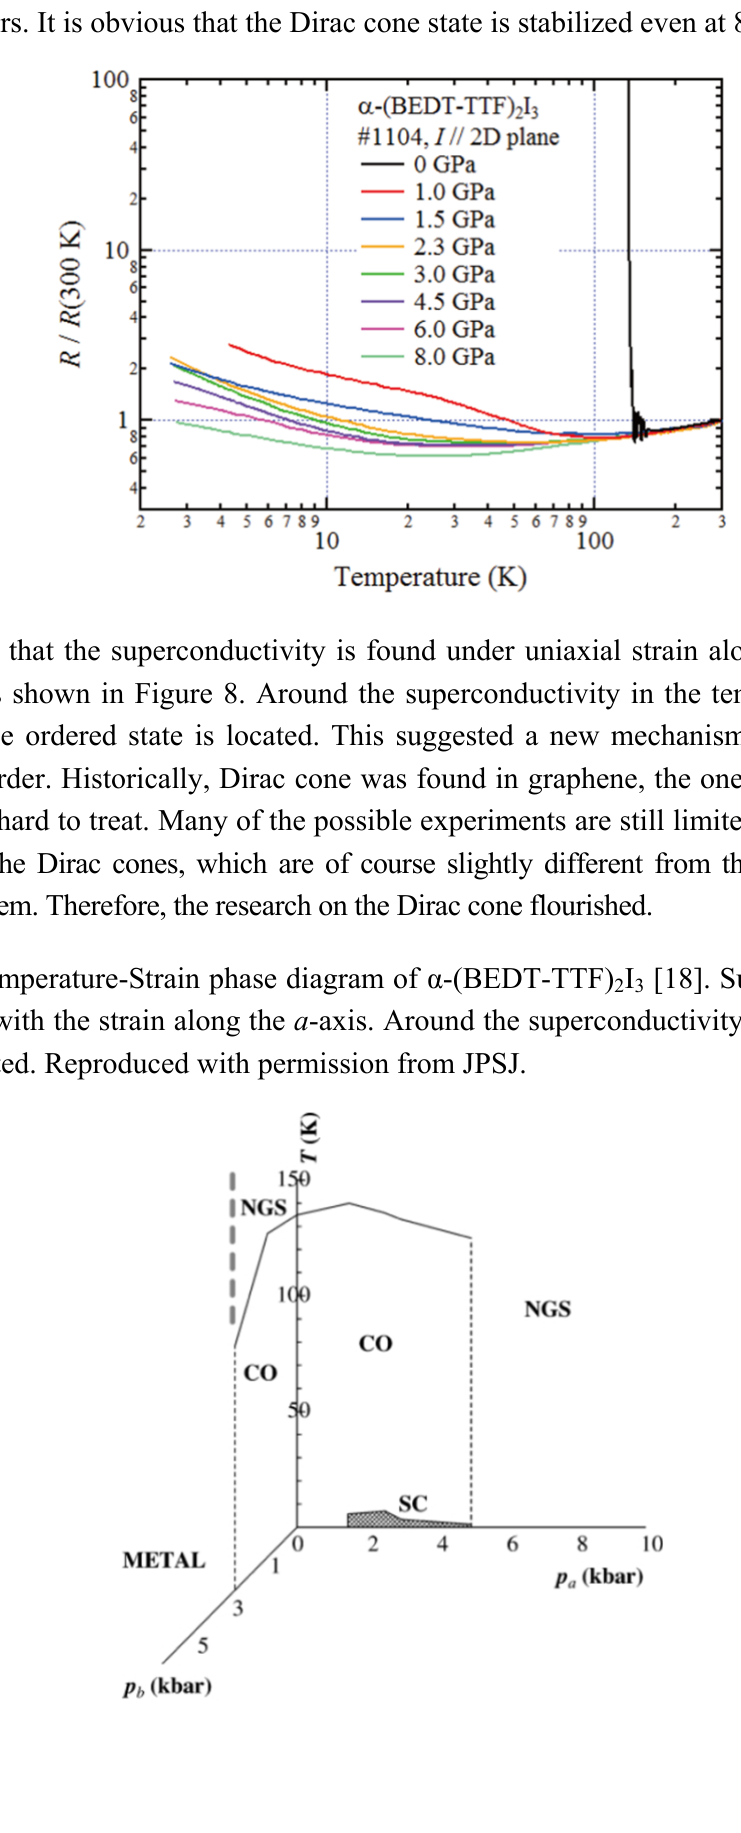
I as examined by the 2 3